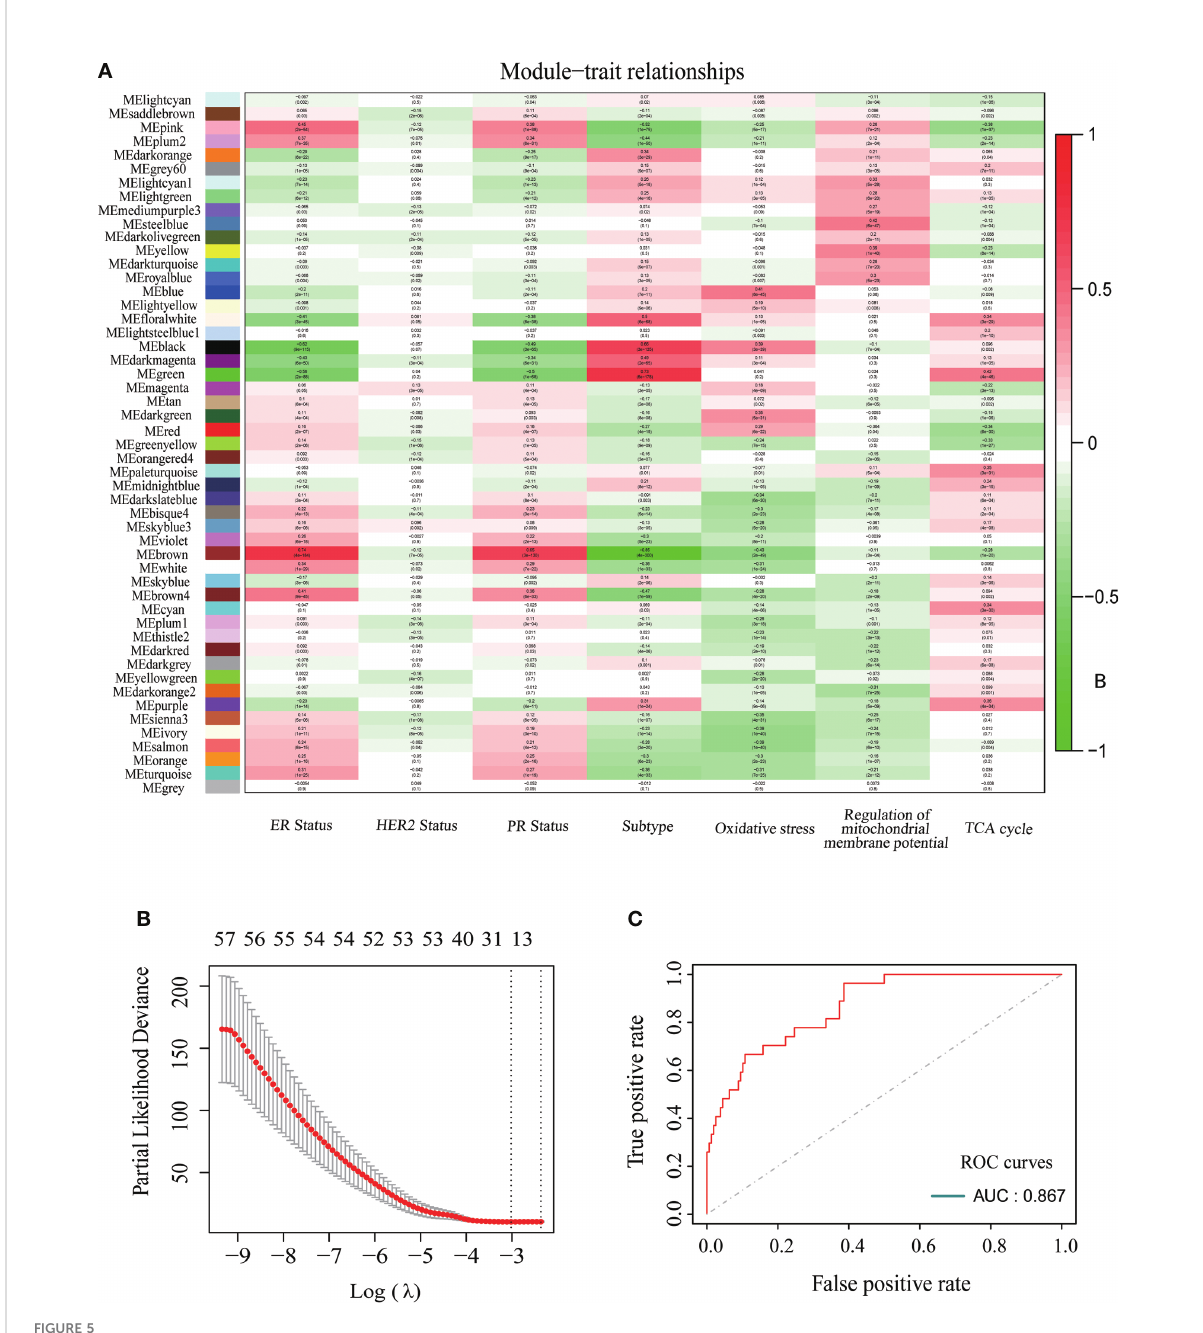
FIGURE 5 The construction of CDKN2A-derived prognostic model of TNBC. (A) The relationships between each module and ER status, HER status, PR status, BRCA subtypes, oxidative stress, regulation of mitochondrial membrane potential and TCA cycle. (B) 21 modeling genes determined by lasso algorithm. (C) The ROC curves and AUC value of CDKN2A-derived